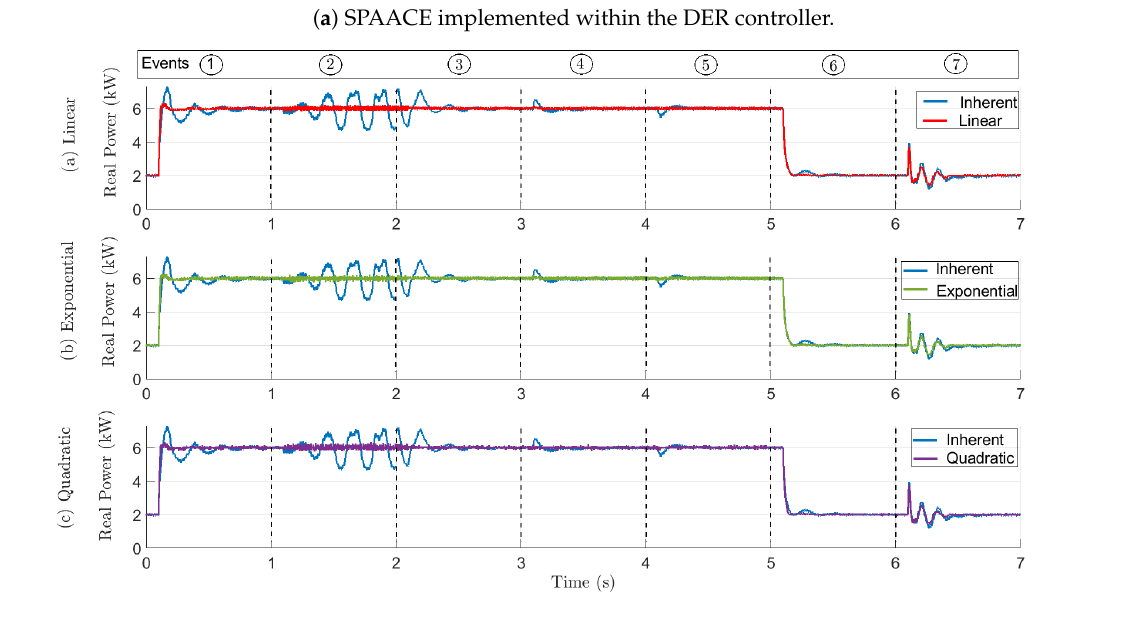
Figure 6. Dynamic response evaluation of SPAACE under grid connected mode of operation with.